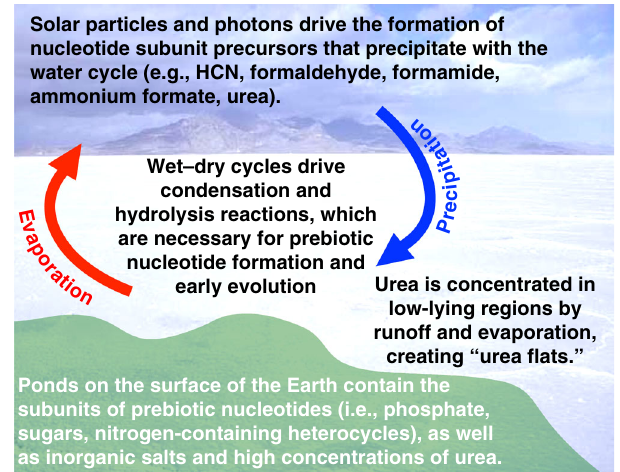
Fig. 2 Illustration of an early Earth environment considered most favorable for nucleotide formation. From top to bottom: Precursors for the synthesis of the organic subunits of nucleotides are formed in the atmosphere of the early Earth with energy provided by photons and solar energetic particles (e.g., high energy protons from the young Sun 15 ). These precursors